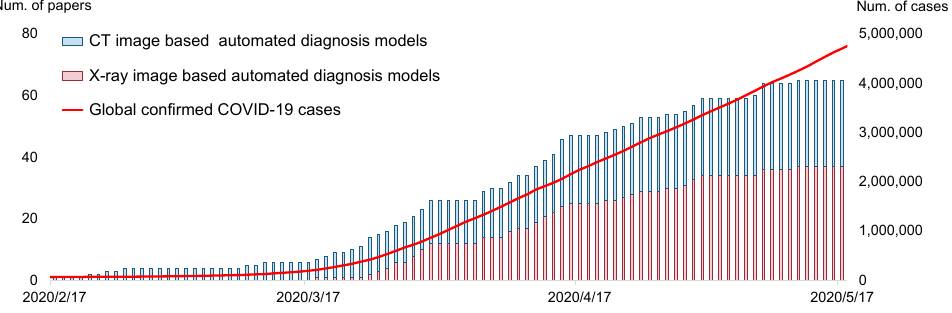
Figure 1. Accumulated count of automated COVID-19 diagnosing models during the 3 months after the first model was proposed (17 February to 17 May 2021). The data are obtained according to the initial submission date on